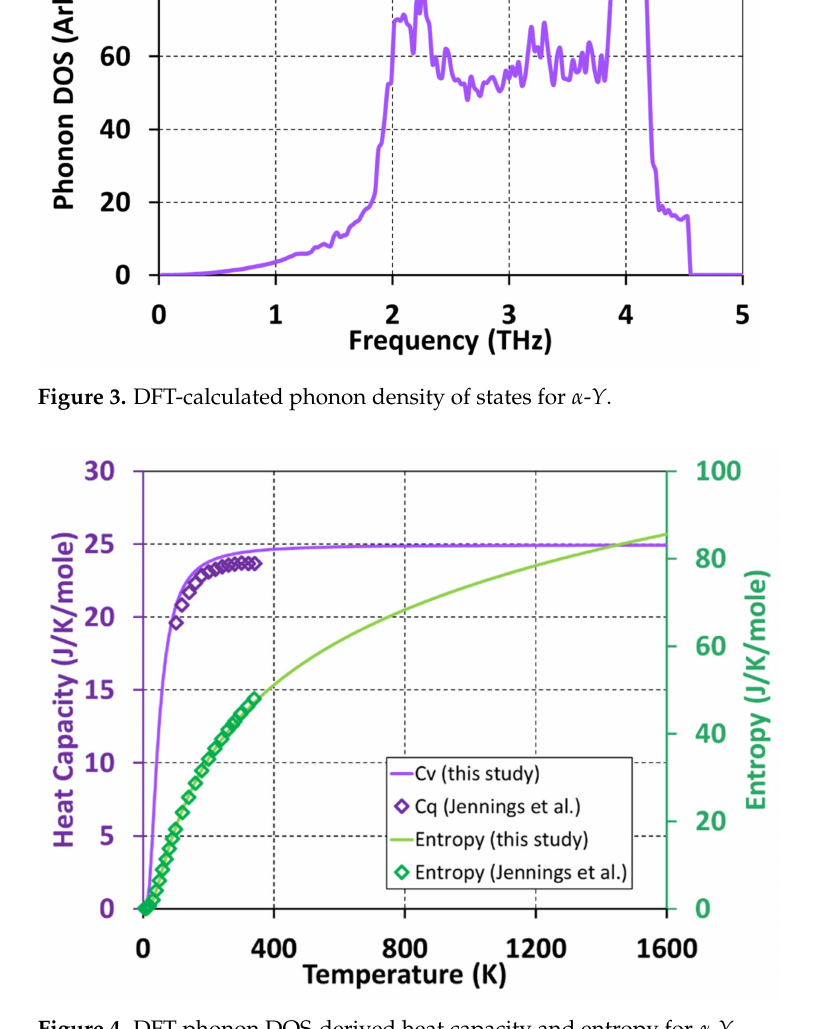
Figure 4. DFT phonon DOS-derived heat capacity and entropy for α - Y